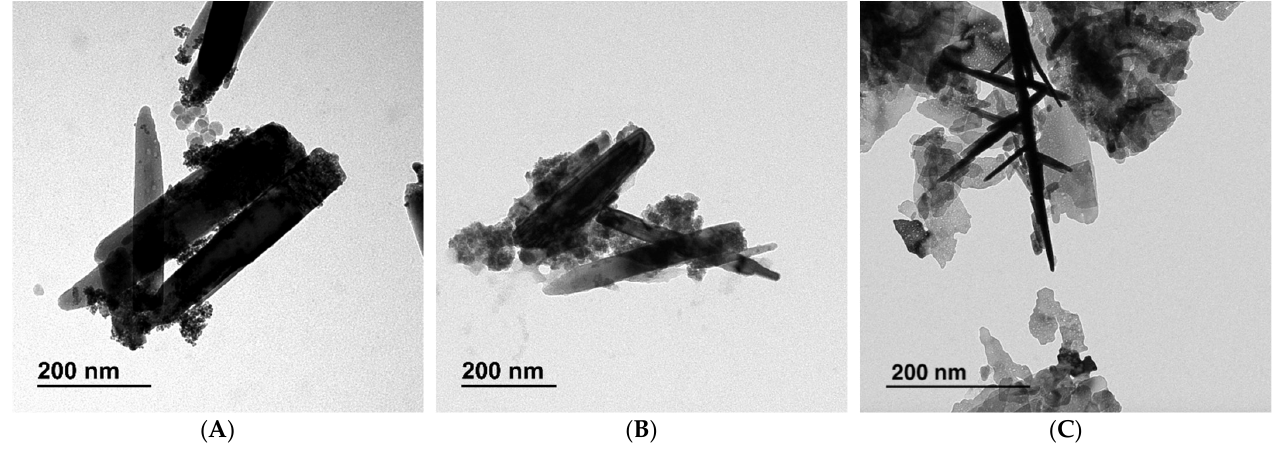
Figure 2. TEM images for ( A ) ZnO, ( B ) Pd ‐ ZnO, and ( C ) Pd ‐ GO ‐ ZnO. The powder diffraction patterns of the ZnO, Pd ‐ ZnO, Pd ‐ GO ‐ ZnO as well as GO materi ‐ als are presented in Figure 3. The diffractogram belonging to the GO material exhibited a characteristic pattern evidencing a peak at the scattering angle at ca. 11 degrees corresponding to the (001) plane of GO [28]. The diffractograms of the ZnO ‐ containing materials presented strong peaks which can be indexed to the wurtzite ‐ type hexagonal phase of ZnO [29]. The Pd ‐ ZnO material did not exhibit any characteristic peak which could be indexed to Pd or Pd oxide species. This behavior may be attributed to the occurrence of very small crystallite size highly dispersed on the ZnO material [30]. Furthermore, the Pd ‐ GO ‐ ZnO diffractogram did not ex ‐ hibit neither peaks form GO nor Pd. The absence of Pd peaks may be related to the high dis ‐ persion as discussed above. As for the lack of GO characteristic peak, it can be attributed to the reduction of GO into reduced GO during the microwave hydrothermal treatment during the synthesis procedure [31].